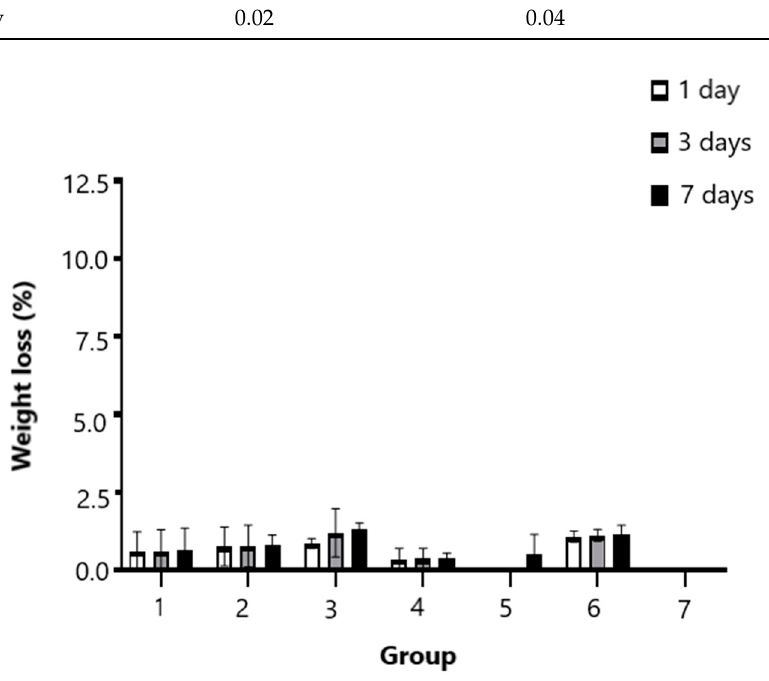
Figure 1. Composite resins: representation of weight loss after acid challenges.